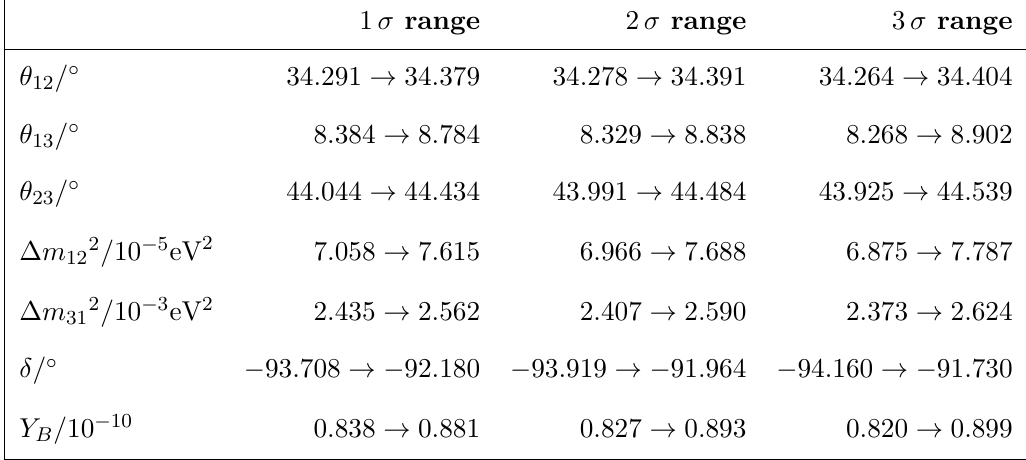
Table 5 . Case D2 ranges for